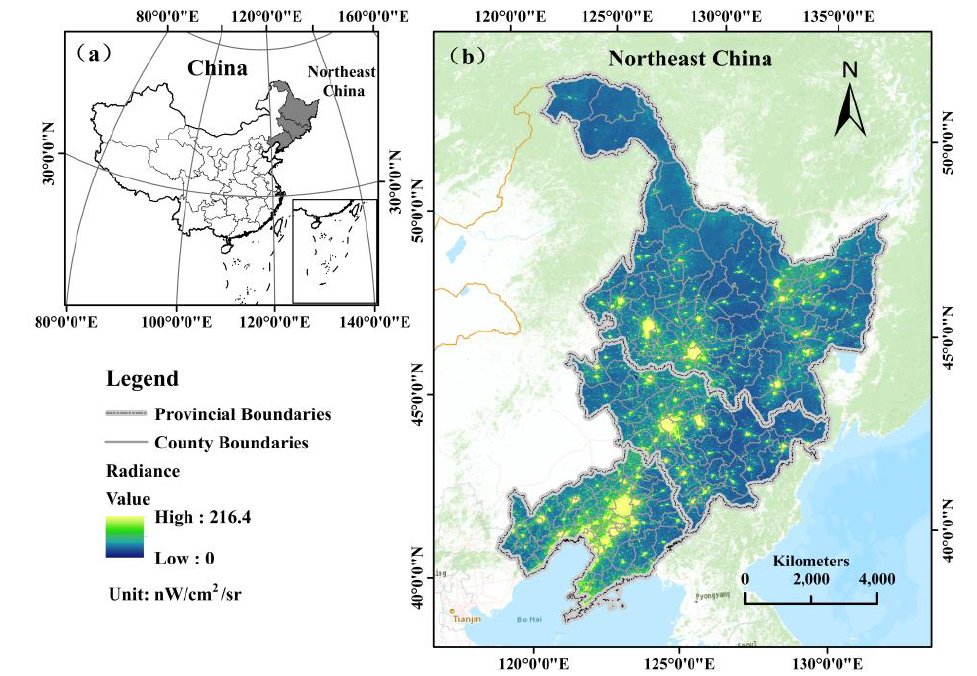
Figure 1. ( a ) Location of the study area; ( b ) NTL radiance (nW/cm 2 /sr) in 2020.